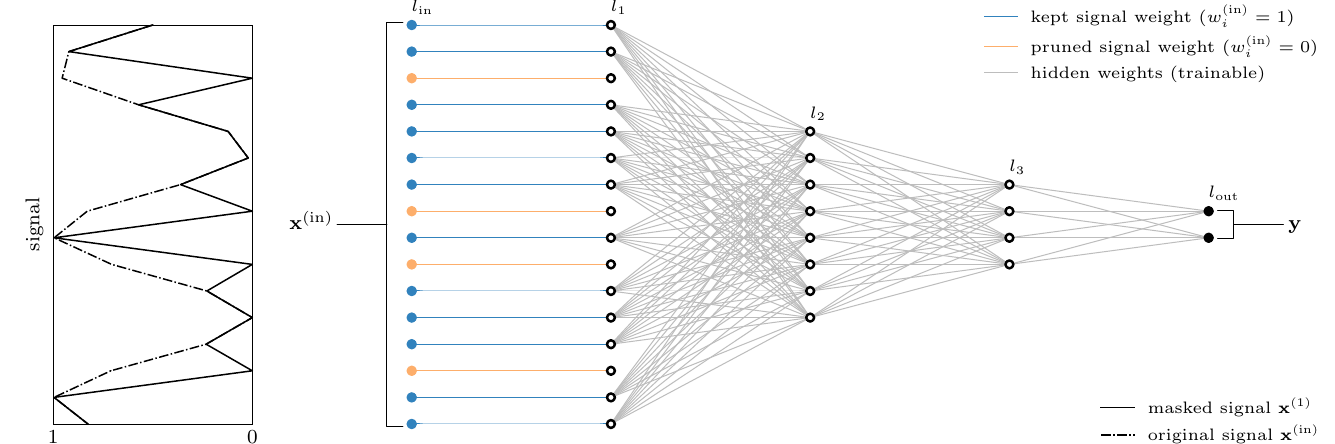
Figure 3. The LinearPass layer ( l in ) precedes a conventional FC architecture with several hidden layers ( l 1 − 3 ) and induces masking ability. Straight connections between the first two layers indicate the weight vector w of this layer. The sinusoidal signal in this example is incomplete, since some of the features have already been